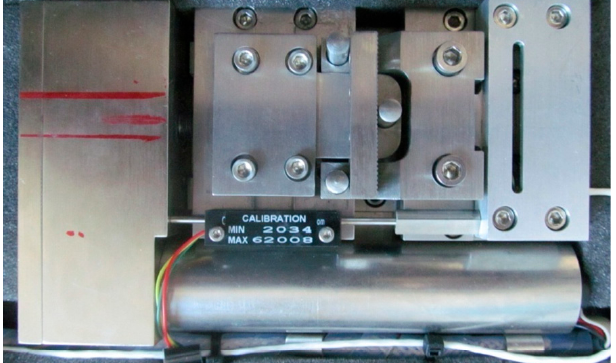
Figure 2. Deben MICROTEST three-point bending stage for the in situ SEM test.